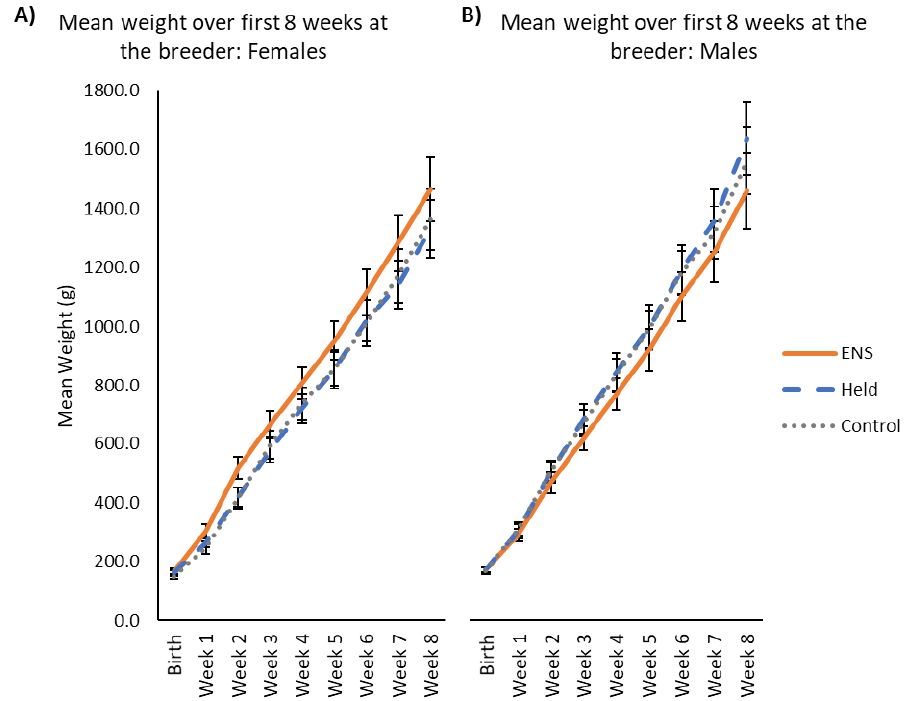
Figure 4. Mean weight for ( A ) female and ( B ) male puppies in each treatment group over the first eight weeks at the breeder’s kennel, prior to application of stressors. Error bars represent the standard errors of the means.